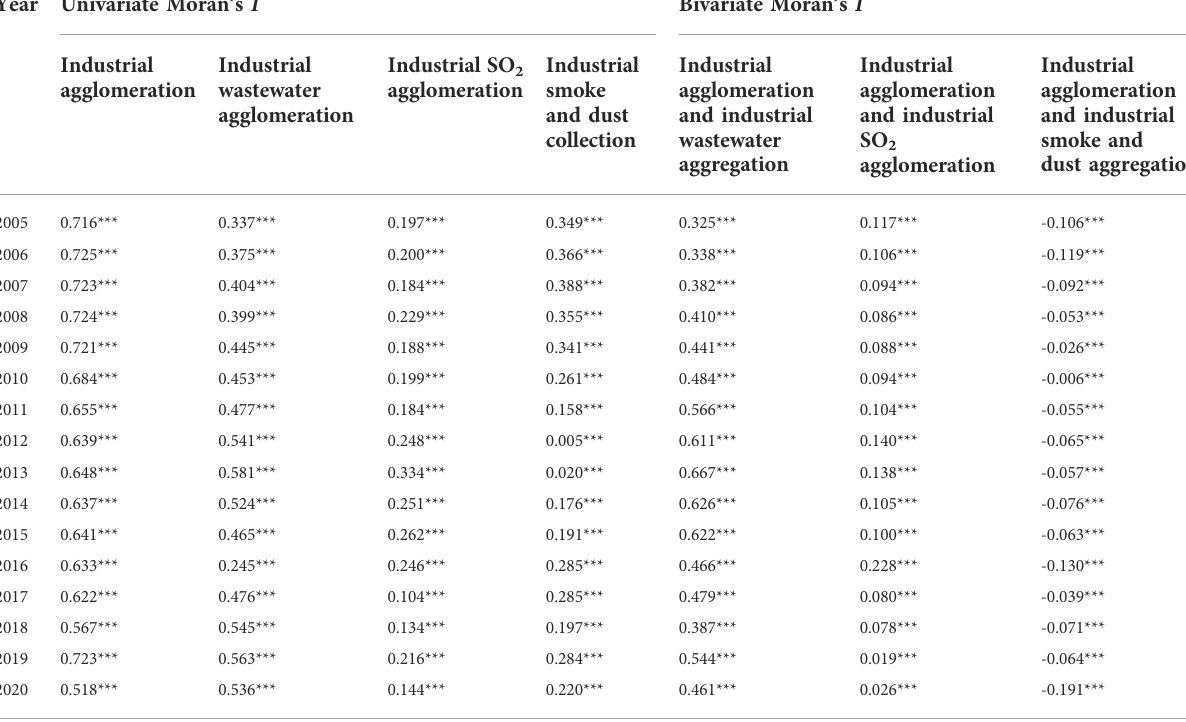
TABLE 1 Moran ’ s I statistics on industrial agglomeration and pollution agglomeration in the Yellow River Basin in 2005 – 2020.